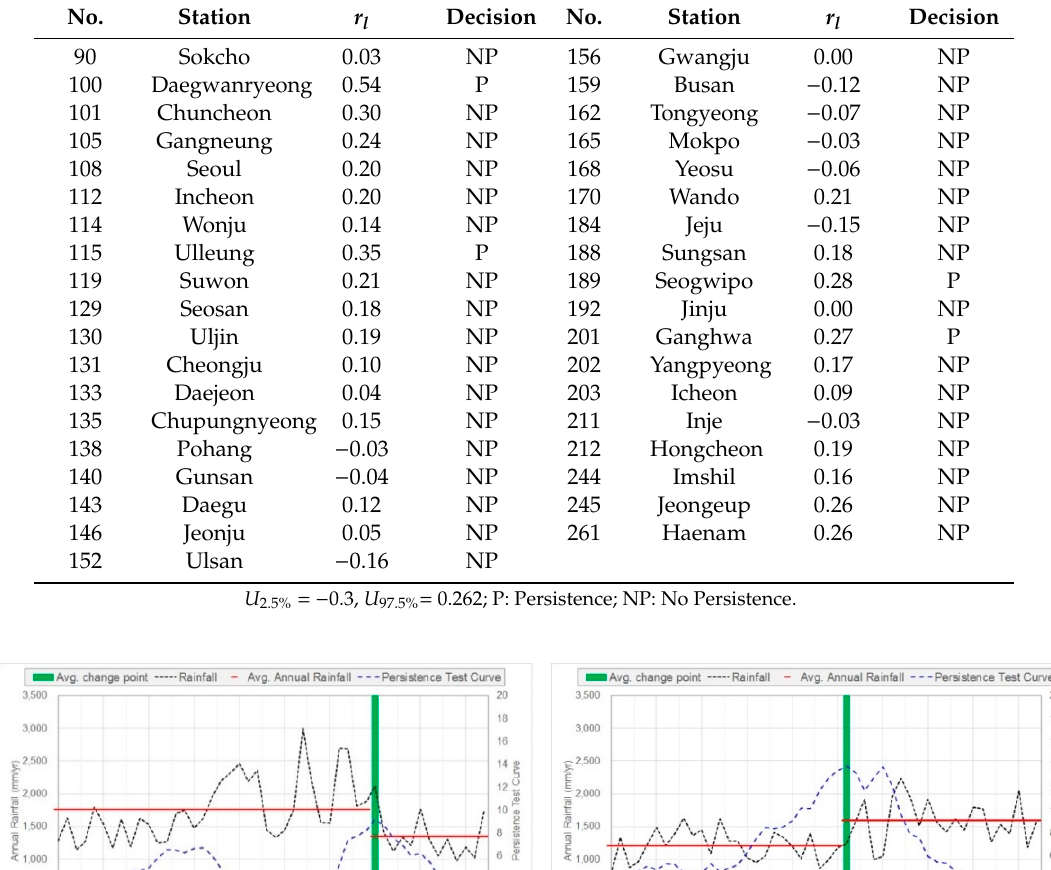
Table 2. Serial correlation coe ffi cient analysis for annual precipitation data.